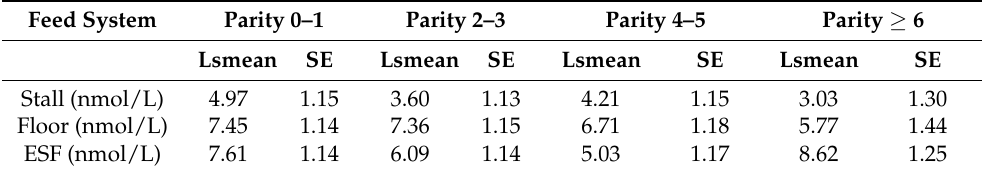
Table 2. Salivary cortisol concentrations (nmol/L) of sows at different parities in different feed systems with free-access feeding stalls (Stall), floor feeding (Floor), and electronic sow feeding (ESF) presented as least square means (lsmeans) and standard errors (SE). The parity reflects the current parity at gestation, so parity 0 equals gilts pregnant with their first litter and so on.